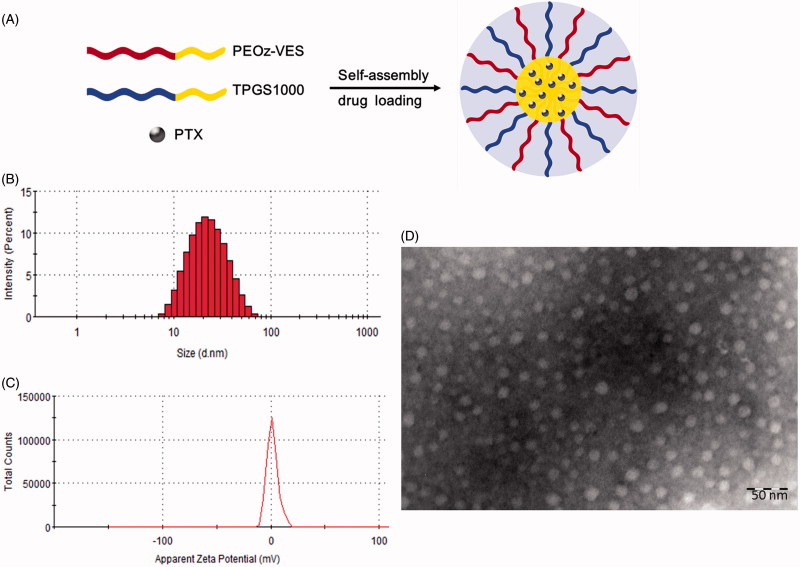
(A) Schematic illustration of self-assembly for PTX/Mix-PMs in aqueous medium. Size (B), Zeta potential (C), and transmission electron microscope images (D) of PTX/Mix-PMs.